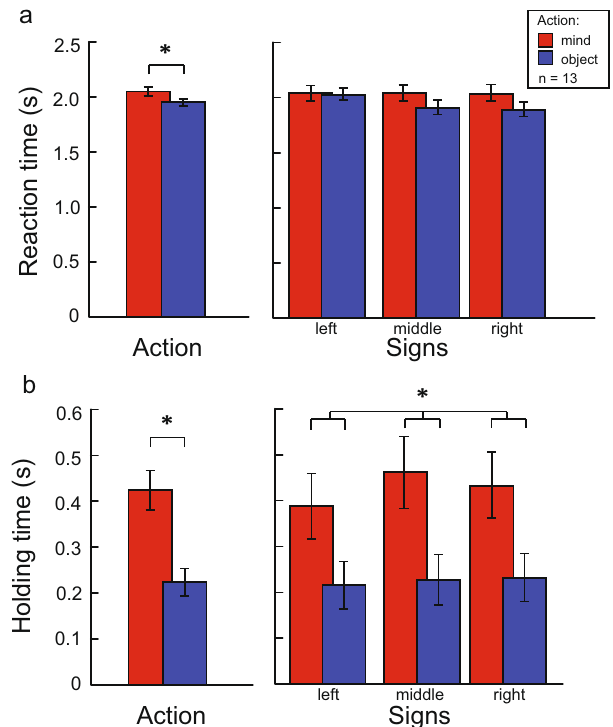
Figure 2. Reaction and holding times. Mind-oriented actions are represented by red bars and object- oriented actions by blue bars. ( a ) Reaction time communicator: the time from stimulus presentation to the communicator initiating the pointing movement. * Indicates a significant main effect of action ( p < 0.05). ( b ) Holding time: the time that the finger was held still within the proximity of the selected sign. * Indicates significant action main and action x sign interaction effects ( p < 0.05). Error bars represent standard errors of the